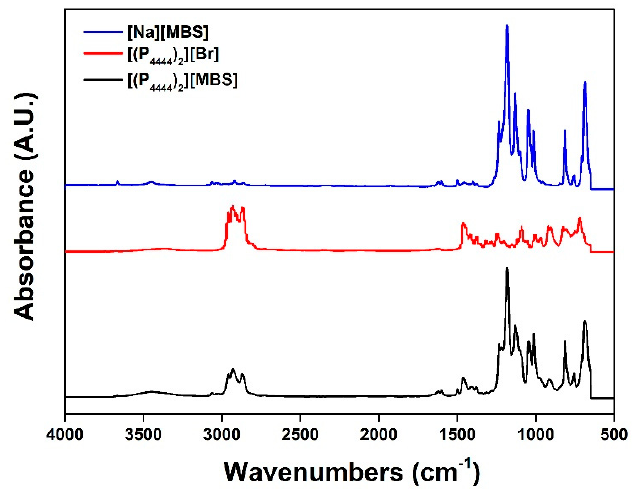
Figure 4. FT-IR spectra of aqueous of [Na][MBS], [(P 4444 ) 2 ][Br], and [(P 4444 ) 2 ][MBS] at room temperature.